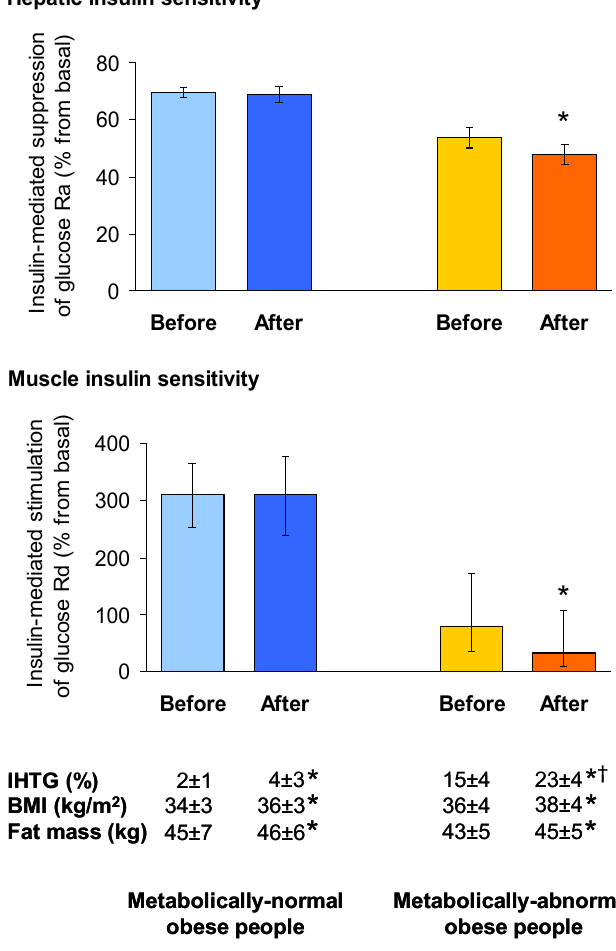
Figure 1. NAFLD as a marker of metabolic dysfunction. Metabolically-normal ( n = 12) and metabolically-abnormal ( n = 8) obese people, defined as having low or high intrahepatic triglyceride (IHTG) content, respectively, but matched on body mass index (BMI) and fat mass, were prescribed a hypercaloric diet for 7–8 weeks, until they gained ~6% of their initial body weight. Hepatic insulin sensitivity ( top panel ) and skeletal muscle insulin sensitivity ( bottom panel ), determined by using a two-stage hyperinsulinemic- euglycemic clamp, decreased after weight gain in metabolically-abnormal but not in metabolically-normal people, suggesting that low liver fat “protects” against the adverse metabolic effects of moderate weight gain. Drawn with data provided in reference [34]. Values for insulin-mediated suppression of glucose rate of appearance (Ra) are means ± SEMs, and those for insulin-mediated stimulation of glucose rate of disappearance (Rd) are back-log-tra nsformed means with 95% confidence intervals. Hepatic and muscle insulin sensitivity were greater and IHTG content was lower in metabolically-normal than in metabolically-abnormal people, both before and after weight gain, whereas BMI and fat mass were not different. * Value after weight gain is significantly different from corresponding value before weight gain. † Change induced by weight gain (in absolute terms) is greater in metabolically-abnormal than in metabolically-normal